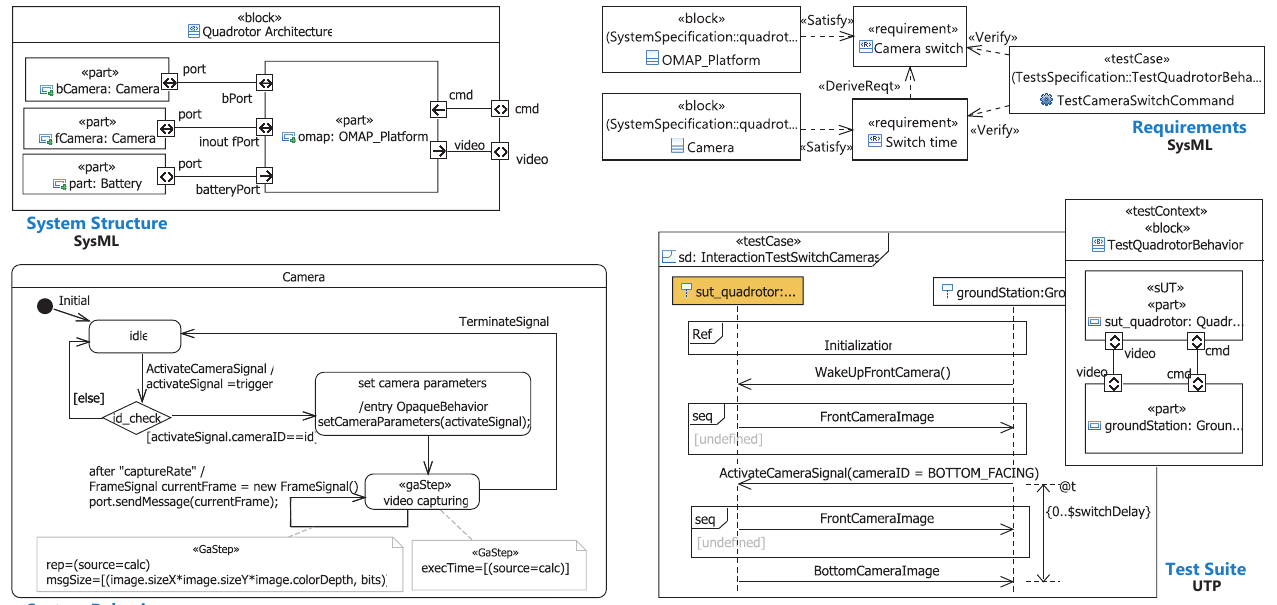
Figure 1: Modeling with OMG